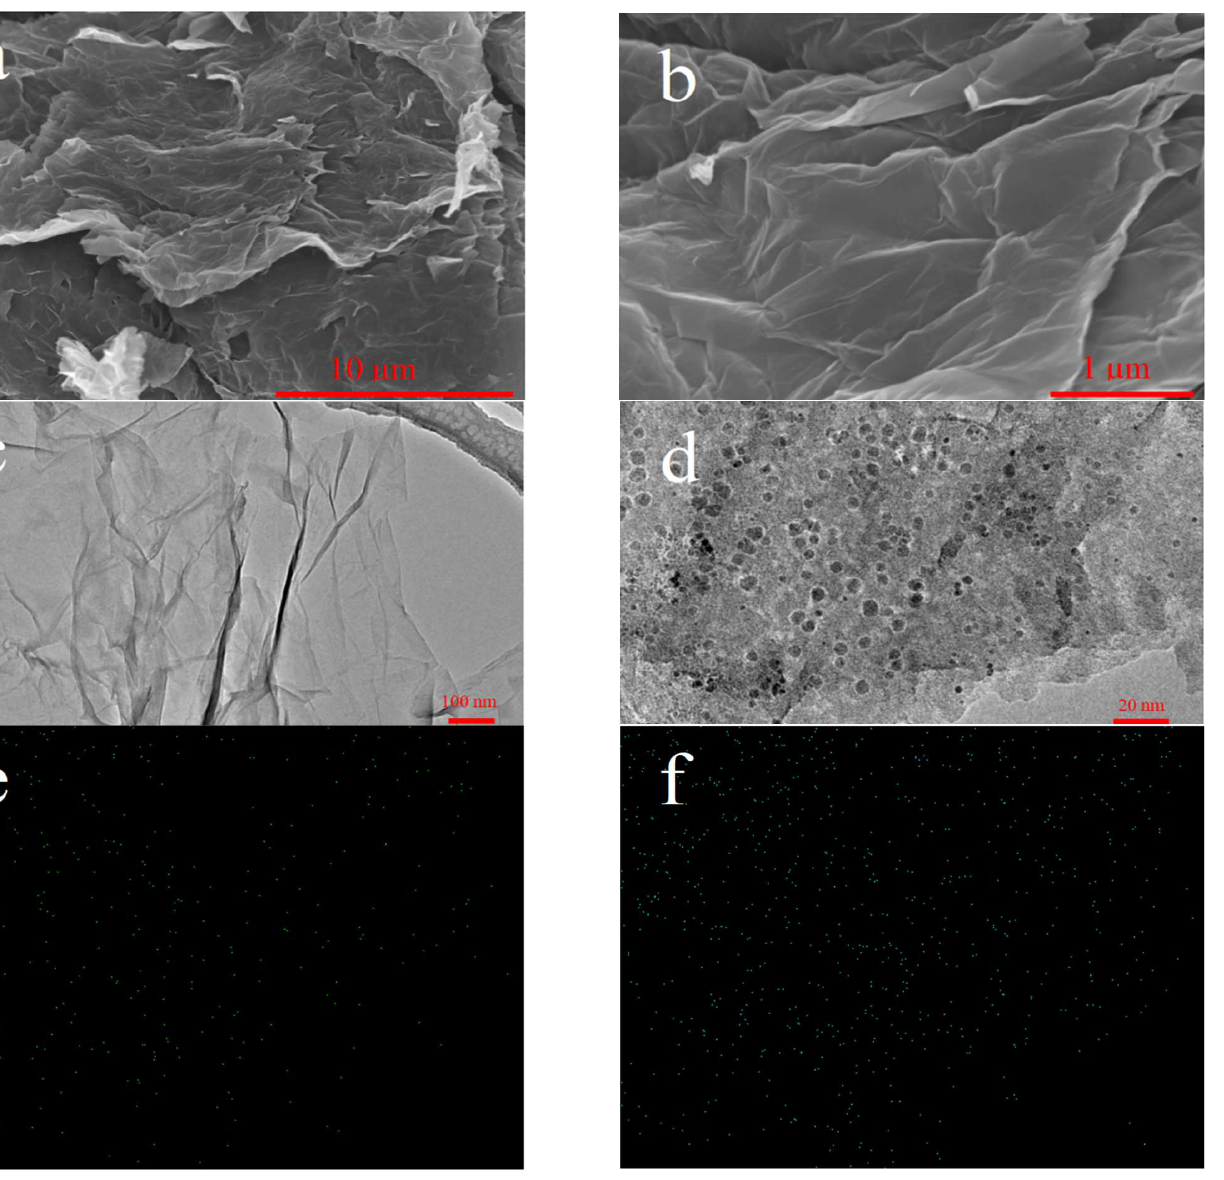
Figure 2. ( a , b ) SEM micrographs of the PtNi/S-(N)rGO; ( c ) HRTEM images of graphene oxide and ( d ) PtNi/S-(N)rGO; Mapping of ( d ) with different elements of ( e )-N element and ( f )-S elements. The Raman spectrum was useful to evaluate the structure defects and doping amount of graphene materials [33]. The peaks of D band (1350 cm −1 ), G band (1583.9 cm −1 ), and 2D (2680 cm −1 ) appeared in the graphene. D band was associated with disordered sp 2 carbon atoms, impurity atoms, defects, or phonon. G band was involved into the vibration of sp 2 carbon atom or the first order scattering of E 2g mode. The peak of 2950 cm −1 reflected a